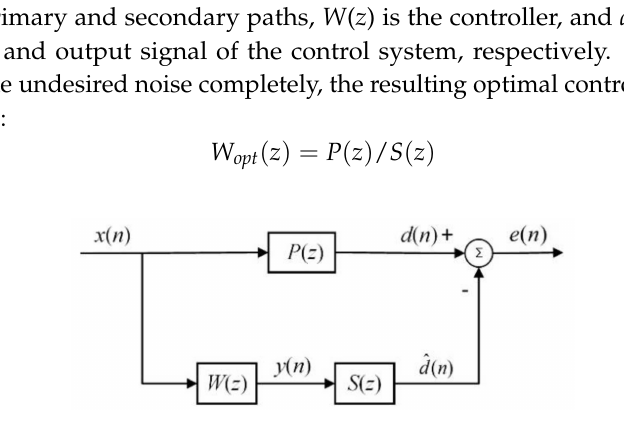
Figure 1. The block diagram of an active noise control (ANC)